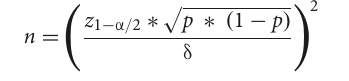
Figure 1 summarized the sample loss during the